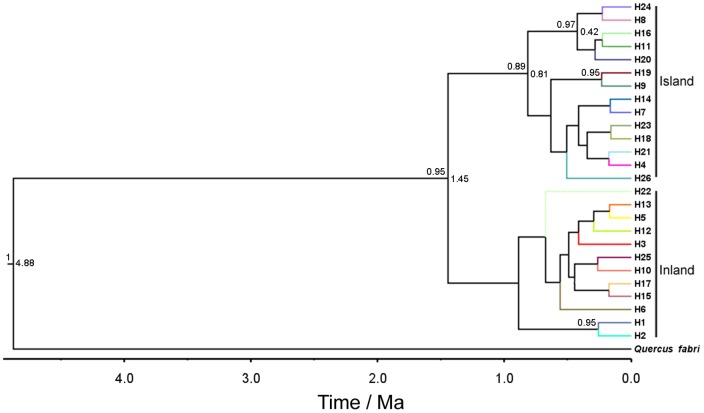
BEAST-derived chronograms of 26 haplotypes of Q. variabilis.The numbers above the branches are posterior probabilities (PP>0.6). Node ages are labeled in the nodes selectively based on posterior probabilities.